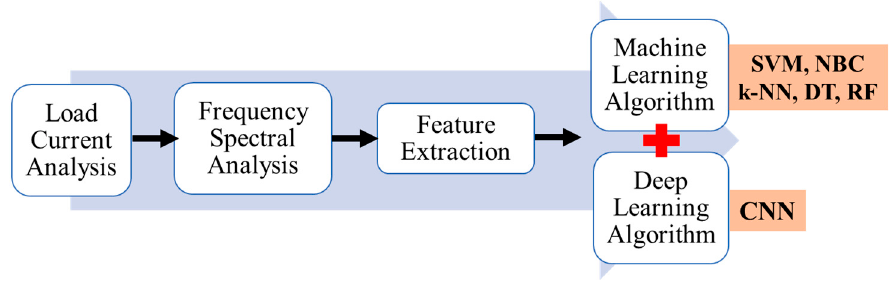
Figure 1. Overview of the proposed method.